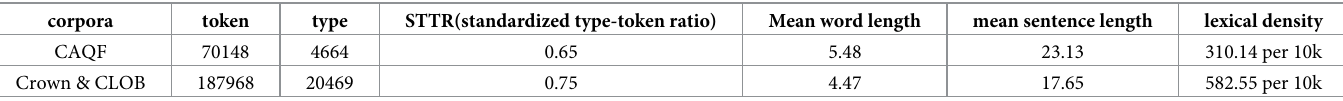
Table 1. Descriptive statistics of